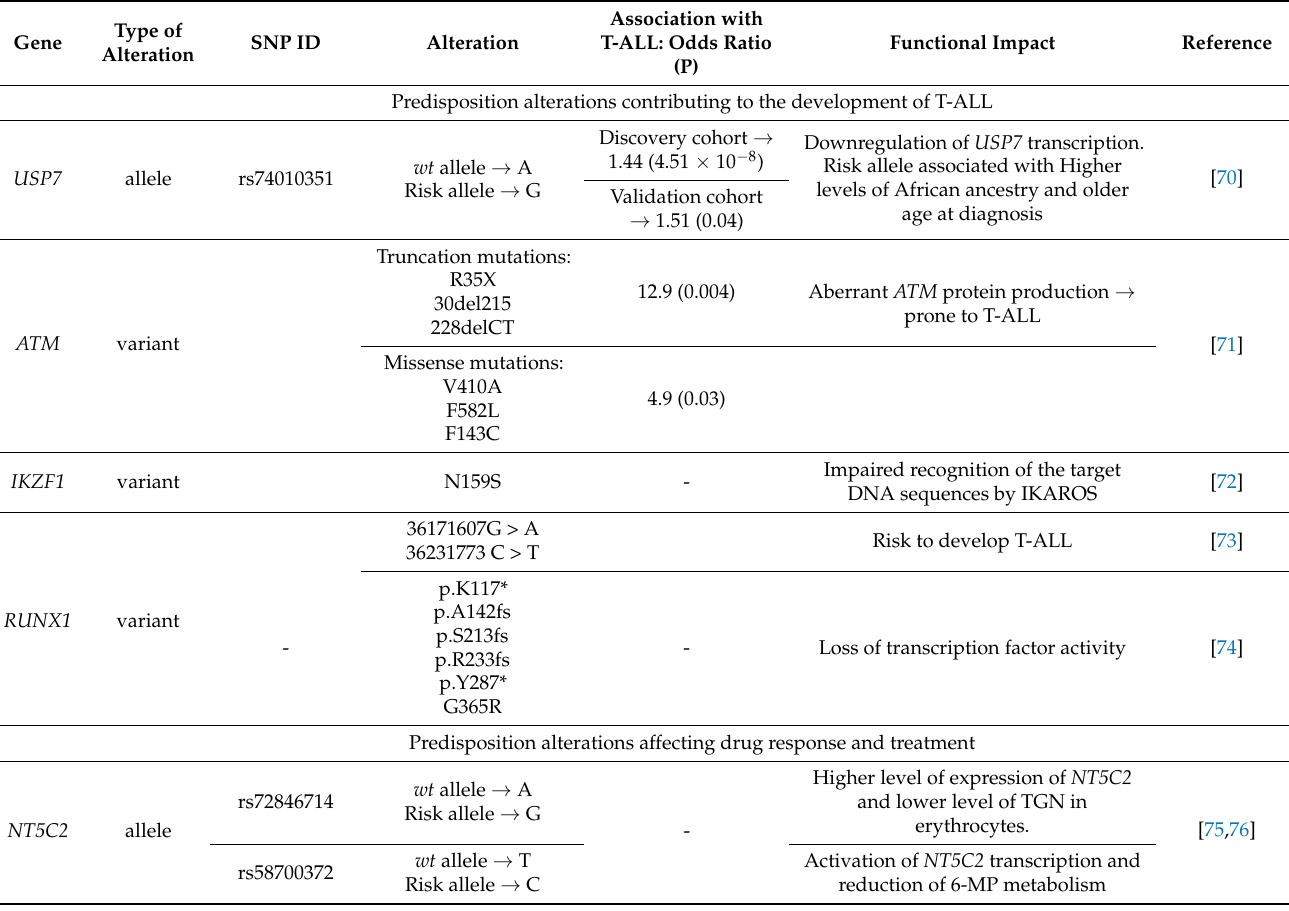
Table 2. Germline variants and predispositions alleles identified in